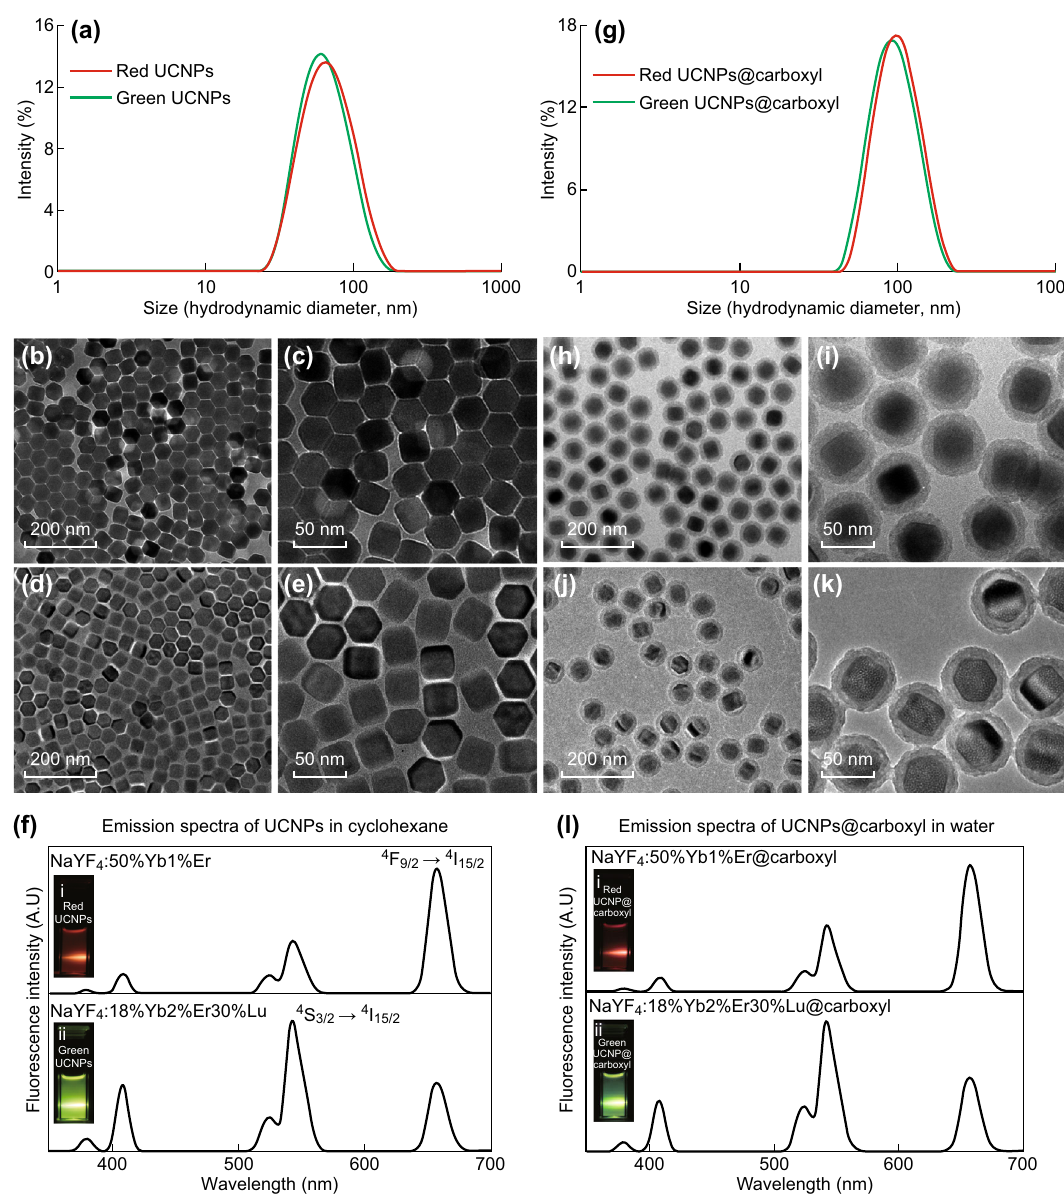
Fig. 2 a Hydrodynamic size and size distribution of NaYF 4 :50%Yb1%Er (red) and NaYF 4 :18%Yb2%Er30%Lu (green) UCNPs in dispersed cyclohexane. TEM images of b, c NaYF 4 :50%Yb1%Er and d, e NaYF 4 :18%Yb2%Er30%Lu UCNPs dispersed in cyclohexane. f Emission fluorescence spectra of NaYF 4 :50%Yb1%Er (top) and NaYF 4 :18%Yb2%Er30%Lu (bottom) UCNPs insets (i, ii) are corresponding camera pictures. g Hydrodynamic size and size distribution of carboxyl-modified NaYF 4 :50%Yb1%Er (red) and NaYF 4 :18%Yb2%Er30%Lu (green) UCNPs dispersed in water. TEM images of carboxyl-modified h, i NaYF 4 :50%Yb1%Er and j, k NaYF 4 :18%Yb2%Er30%Lu UCNPs dispersed in water. l Emission fluorescence spectra of carboxyl-modified NaYF 4 :50%Yb1%Er (top) and NaYF 4 :18%Yb2%Er30%Lu (bottom) UCNPs insets (i, ii) are corresponding camera pictures. (Color figure